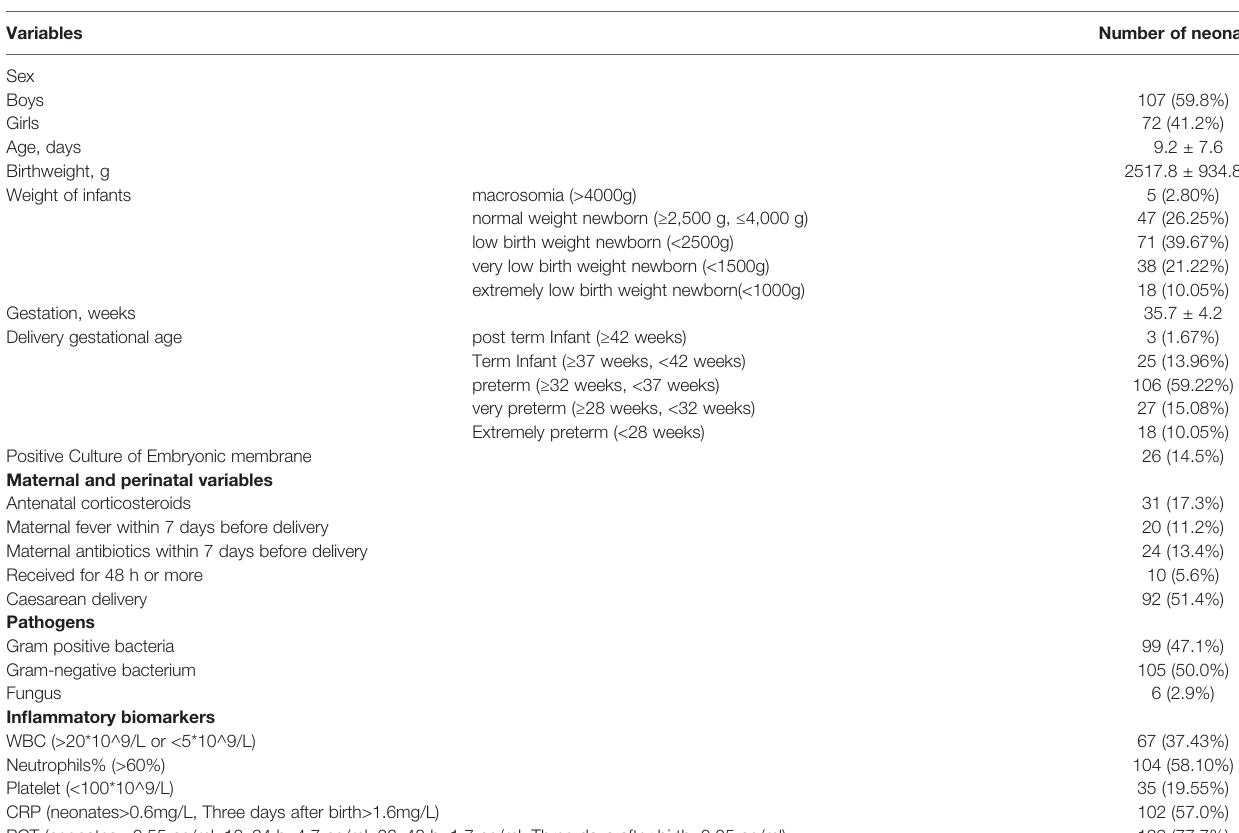
TABLE 1 | Demographic details of enrolled